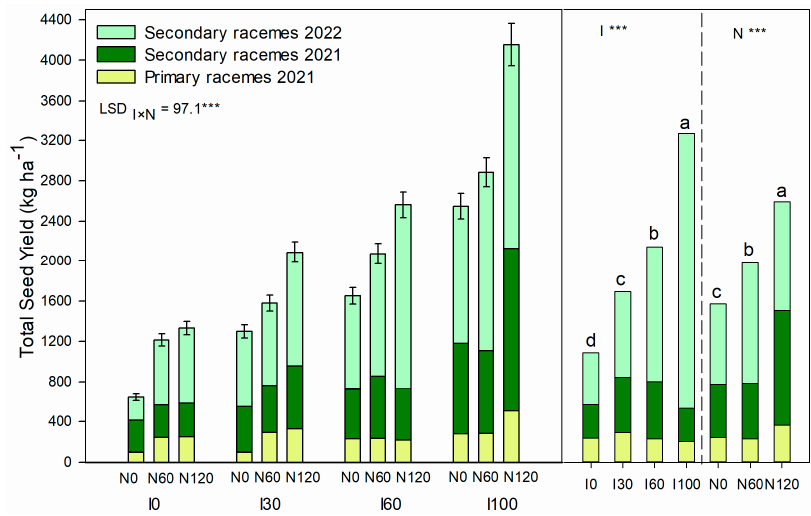
Figure 3. On the left, the total seed yield (kg ha − 1 ) (primary and secondary racemes from 2021 and 2022) in relation to irrigation (I0, I30, I60, and I00 = 0, 30, 60, and 100% ETm, respectively) and N fertilization (N0, N60, and N120 = 0, 60, and 120 kg ha − 1 N) with error bars indicating the standard error. On the right, there is the mean separation of the total seed yield, with different letters representing statistically significant means according to the LSD test ( p ≤ 0.05). The significance levels of the ANOVA for irrigation and N fertilization (*** significant at p ≤ 0.001) and the significant interaction (LSD I × N at p ≤ 0.05) are